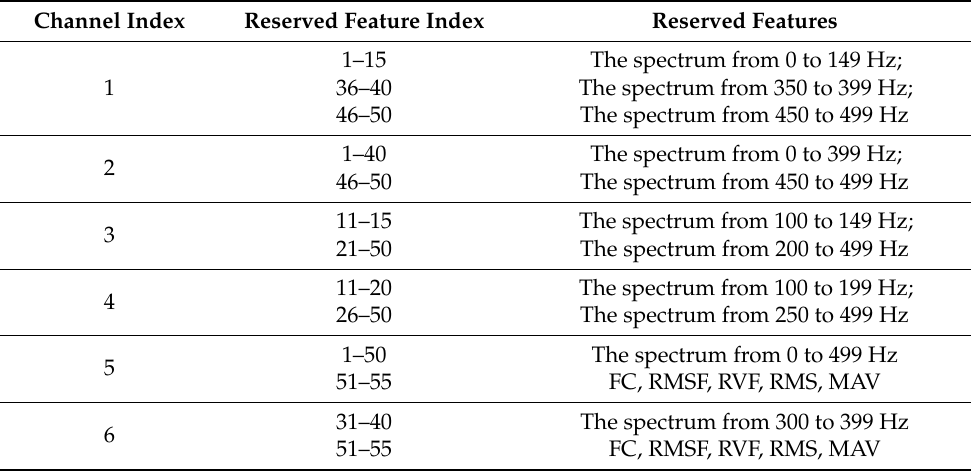
Figure 7. Relation between R 2 NF and NF for taste Sour. For each channel, datasets only containing features from this channel were constructed. NF is the number of features and R 2 NF is the R 2 score of SVM performed on a dataset containing NF features. The red circles are the curves’ chosen inflection points. The figure shows that the trend of R 2 NF changed as the NF changed. Table 5. Reserved features during the feature dimensionality reduction for